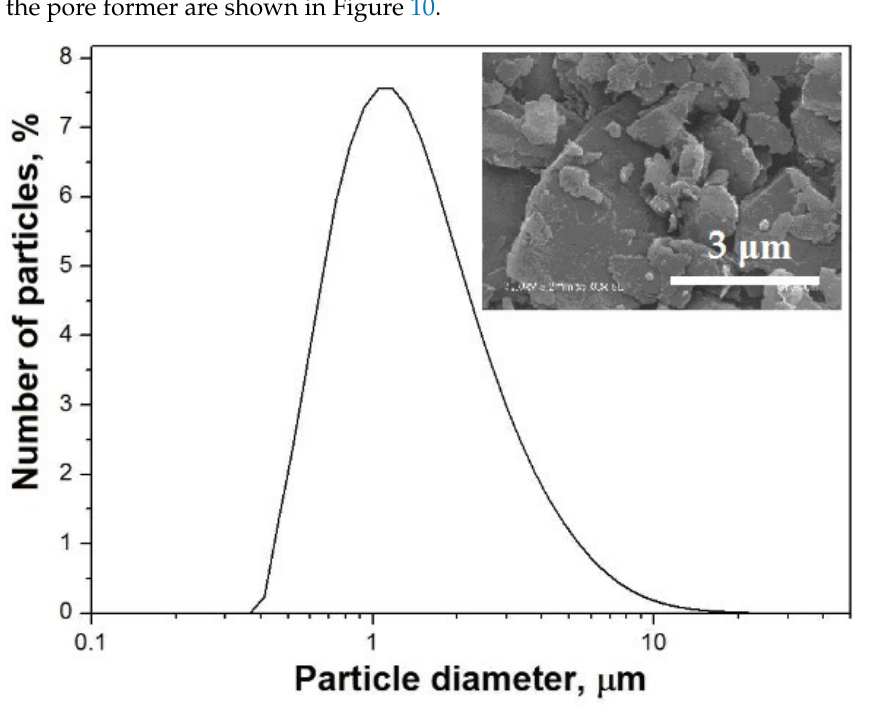
Figure 11. X-ray patterns of the initial NiO/YSZ composite (1), the printed sample with 20 wt.% graphite (2), and the printed sample after sintering (3).